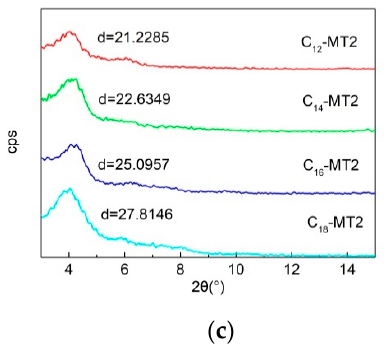
Figure 2. XRD patterns of MT, ( a ) Ca(Na)-MT, ( b ) C n -MT1, ( c ) C n -MT2.